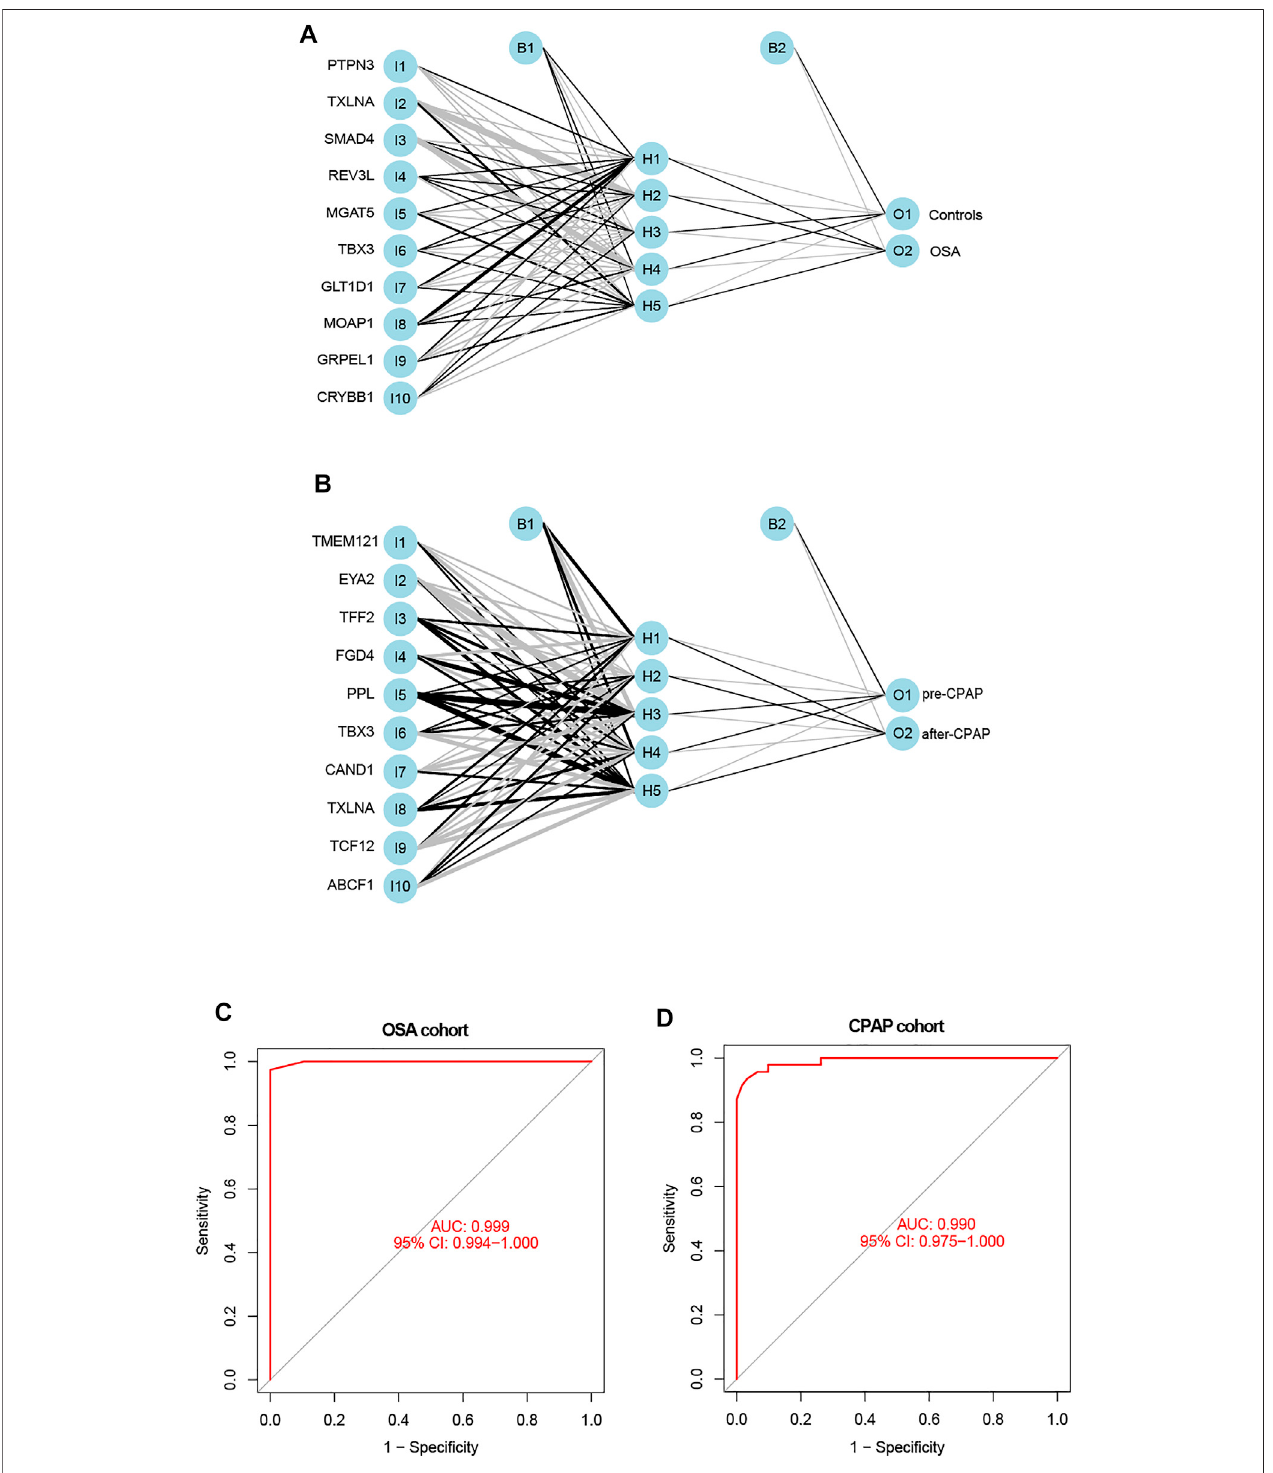
FIGURE5|(A,B) TheconstructionsofanANNfortheOSAcohortandtheCPAPcohortwerecomprisedofoneinputlayer,onehiddenlayer,andoneoutputlayer. (C) ROC curves of the ANN-based OSA diagnostic model. (D) ROC curves of the ANN-based CPAP treatment model.